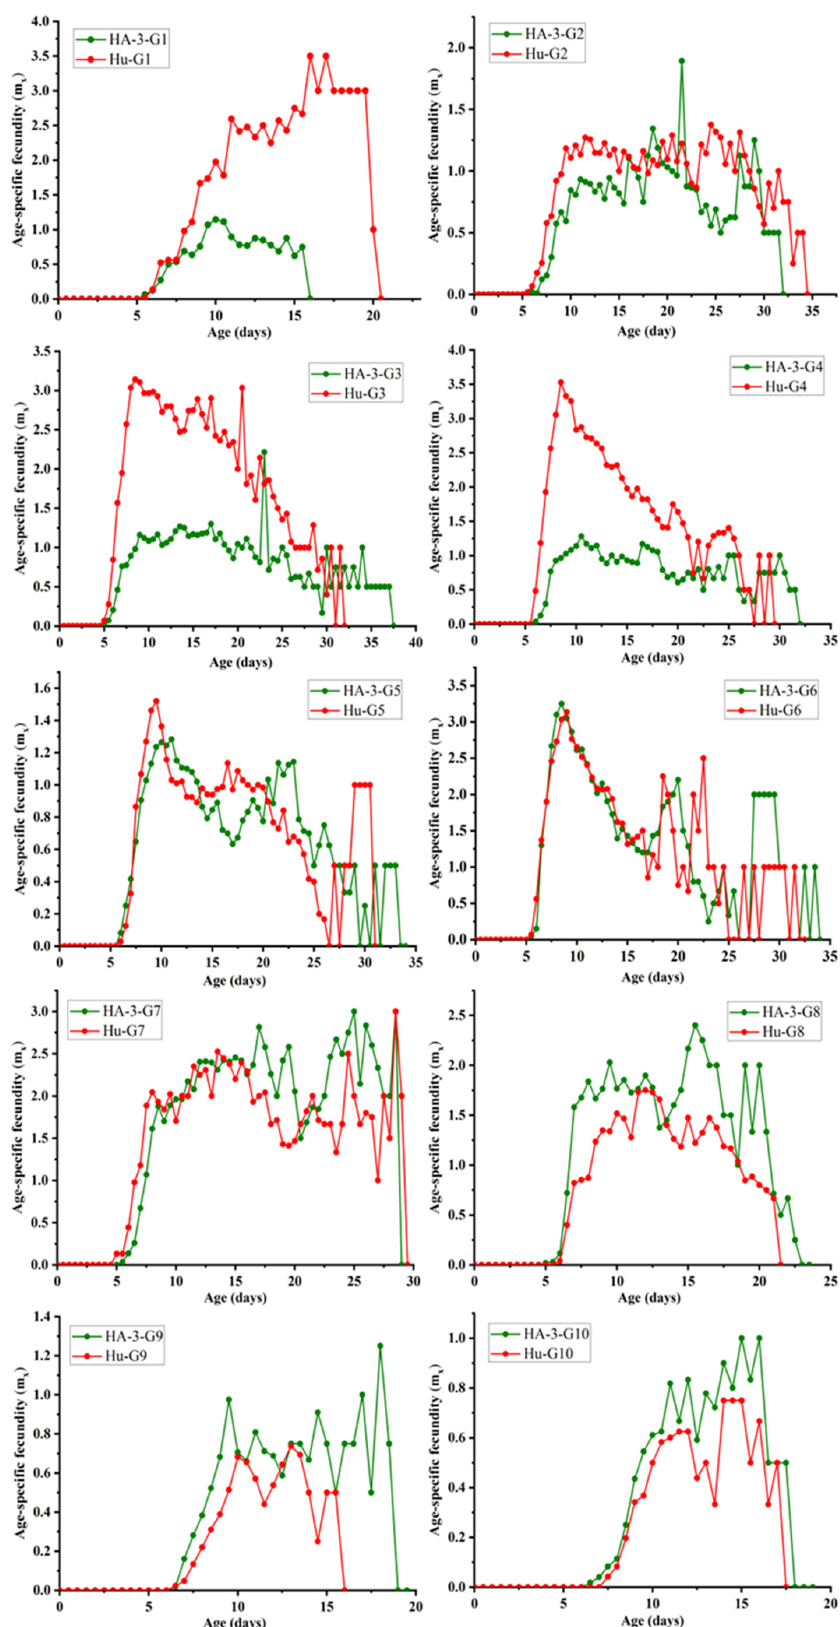
Figure 3. Age-specific fecundity of SAA G1-G10 on HA-3 and Hu cultivars.